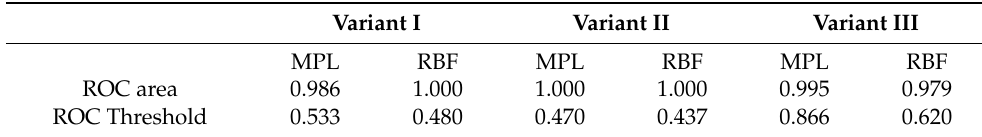
Figure 9. Comparison of ROC curves for all classification variants. Table 4. Area under the ROC curves and ROC